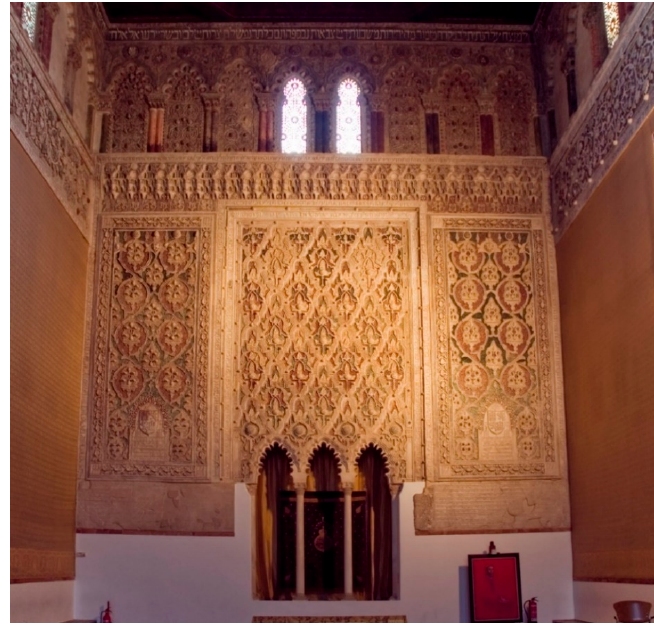
Figure 16. The heikhal of El Tránsito Synagogue. Author’s photo.